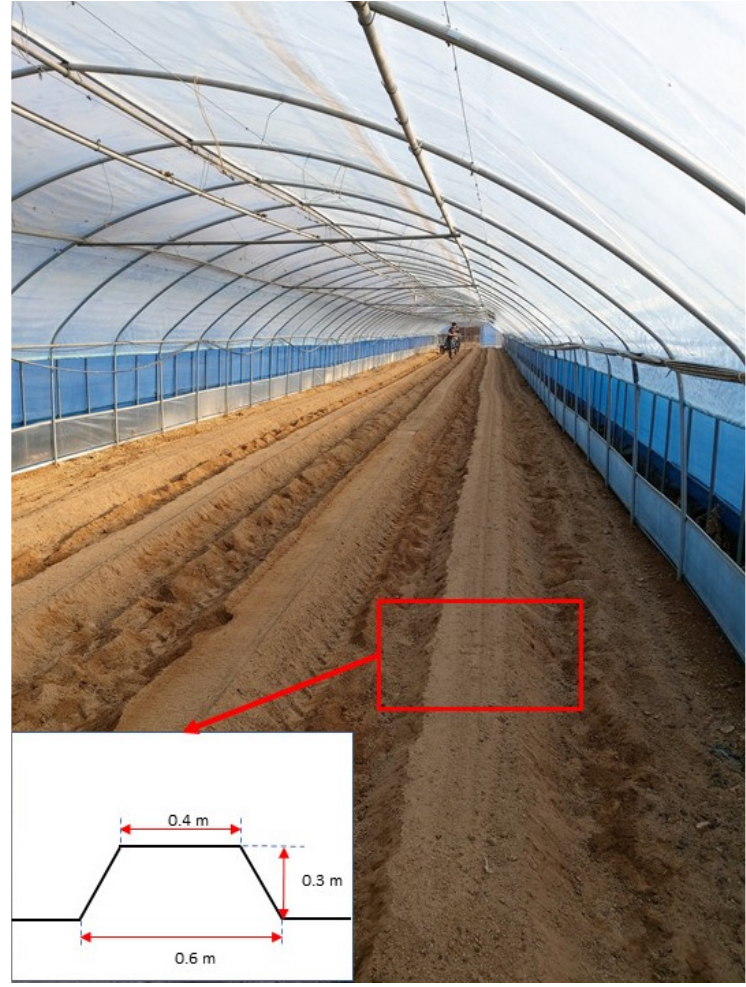
Figure 7. A view of the experimental site.